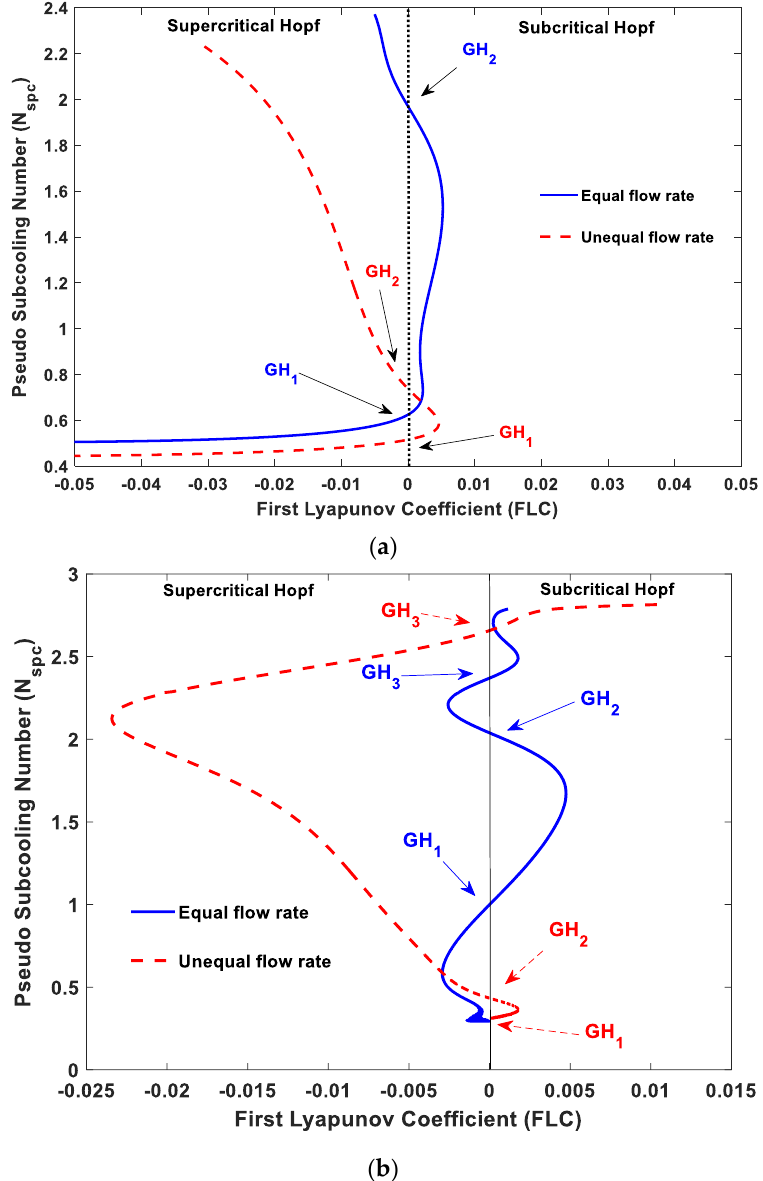
Figure 11. ( a ) The nature of the first Lyapunov coefficient corresponding to Figure 8. ( b ) The nature of the first Lyapunov coefficient corresponding to Figure 9.